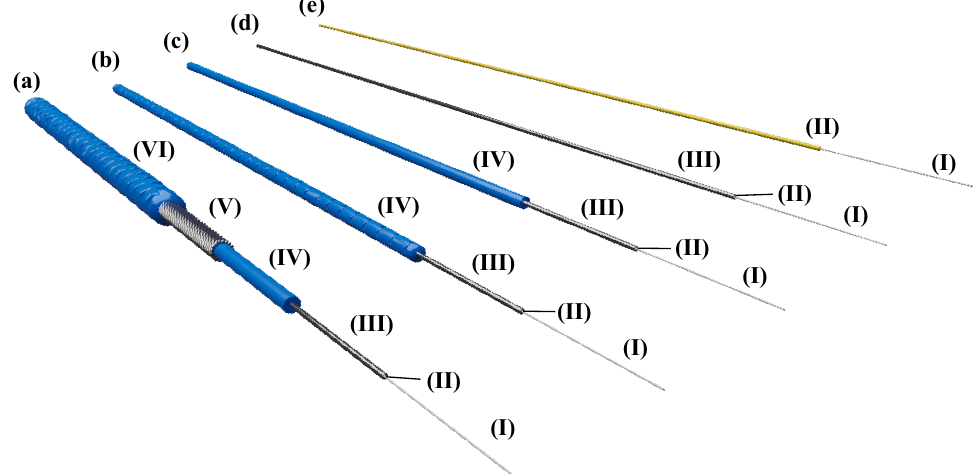
Figure 2. Distributed fiber optic sensing cables for application along concrete structures with (I) strain sensing single mode fiber ( 250 µ m), (II) tight buffer, (III) metal tube, (IV) polyamide protection (cid:31) layer, (V) special steel armoring, and (VI) polyamide outer sheath: ( a ) BRUsens V3. ( b ) BRUsens V9. ( c ) BRUsens V4. ( d ) BRUsens FiMT. ( e ) Tight-buffered